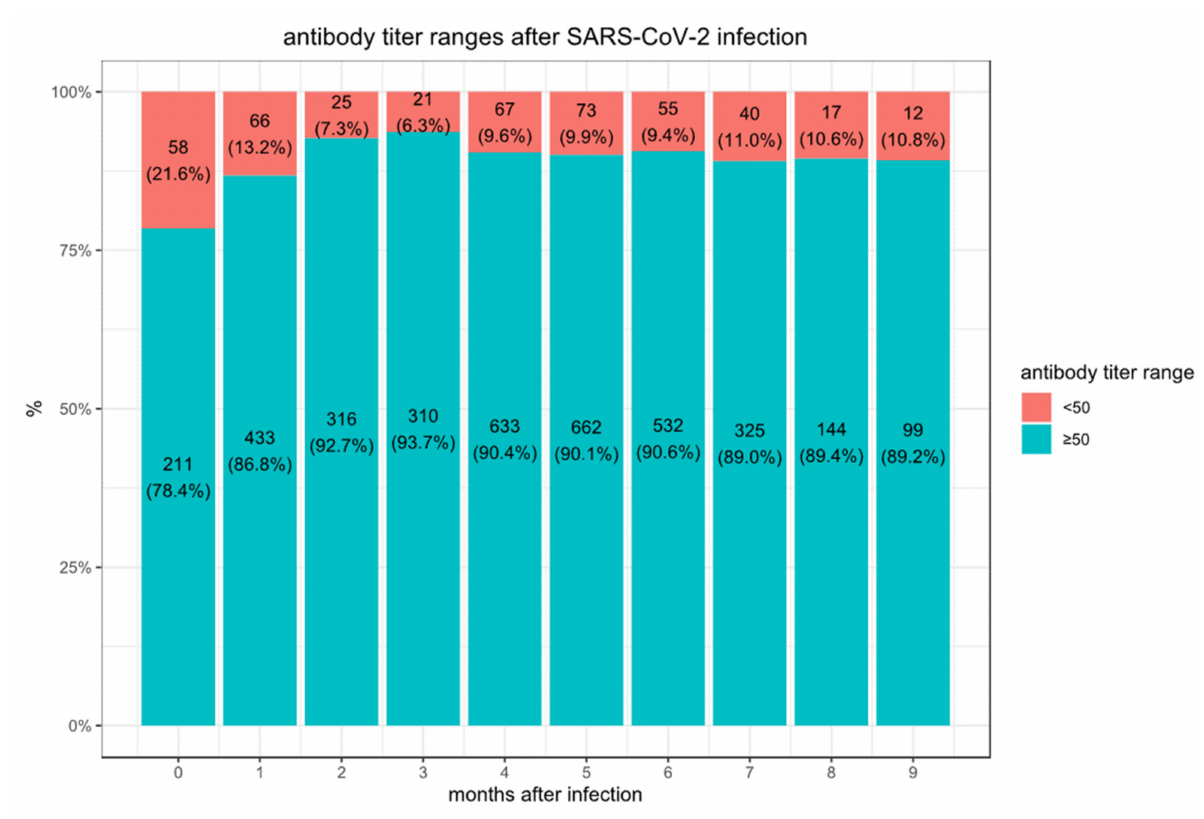
Figure 2. Proportions of convalescent individuals with antibody titers below the protective threshold of